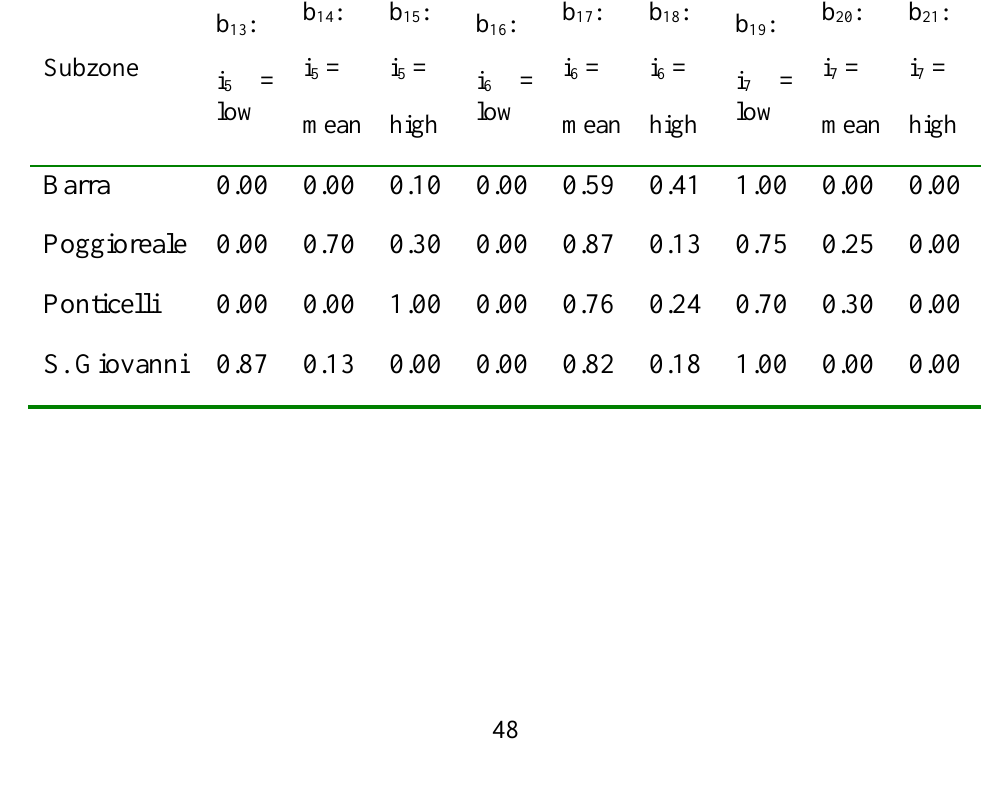
Table 5: TFNs for the symptoms b